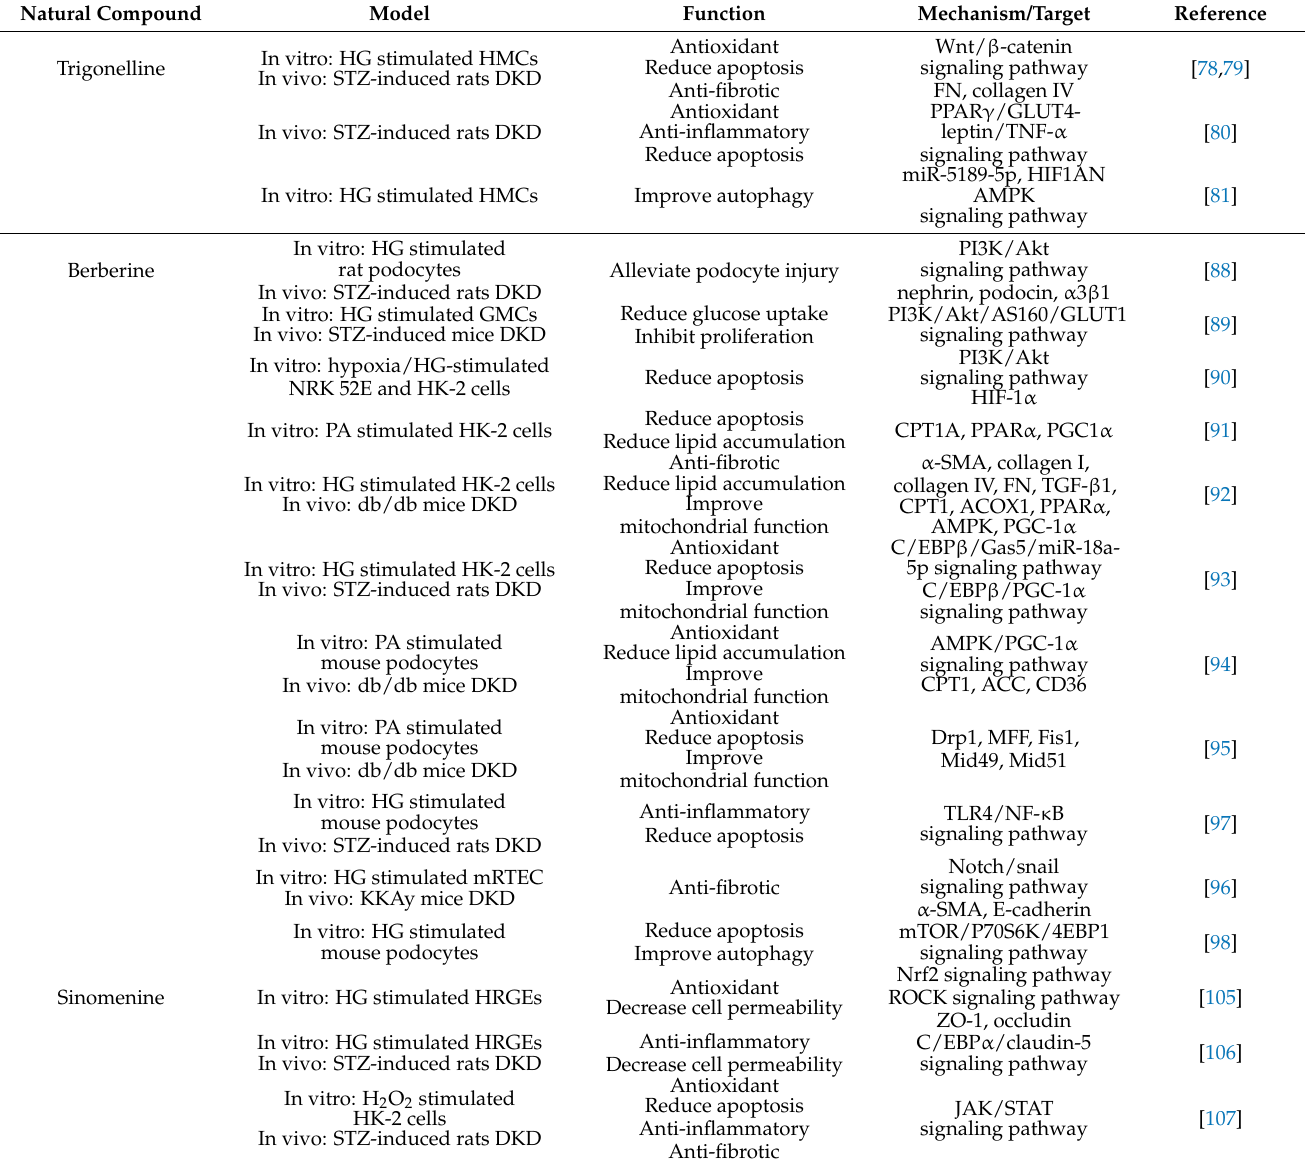
Table 2. Mechanisms of alkaloids in the treatment of